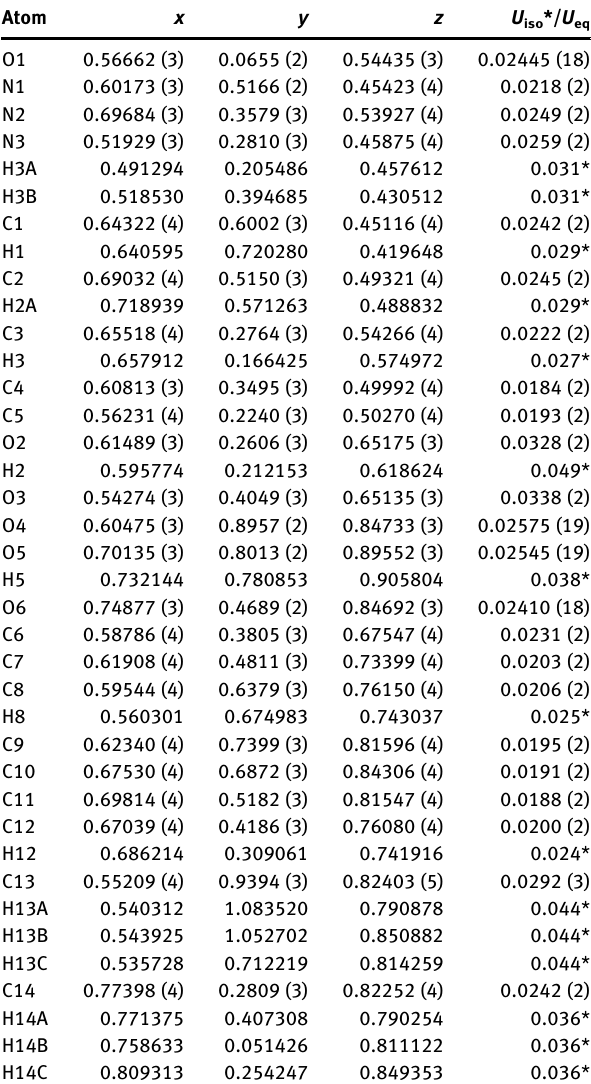
Table  : Fractional atomic coordinates and isotropic or equivalent isotropic displacement parameters (Å 